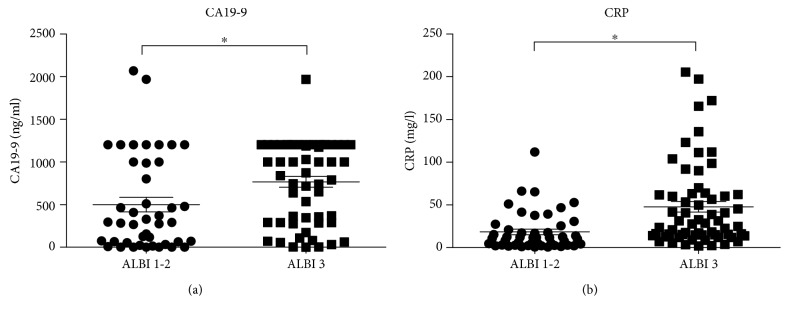
Scatter plots revealing the associations between ALBI grade and CA19-9 (a) and CRP (b) (∗
P < 0.05).